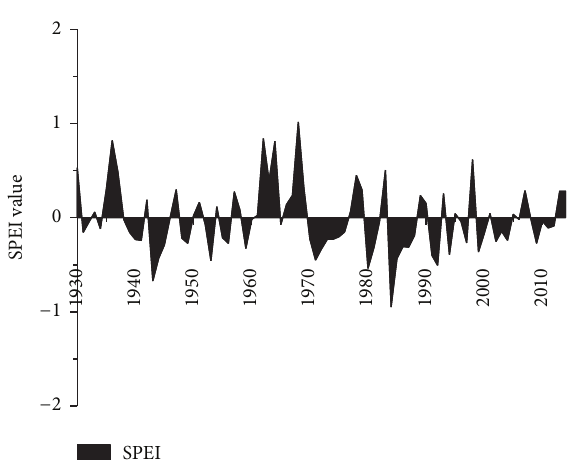
Figure 5: The drought condition of the HOA from SPEI.